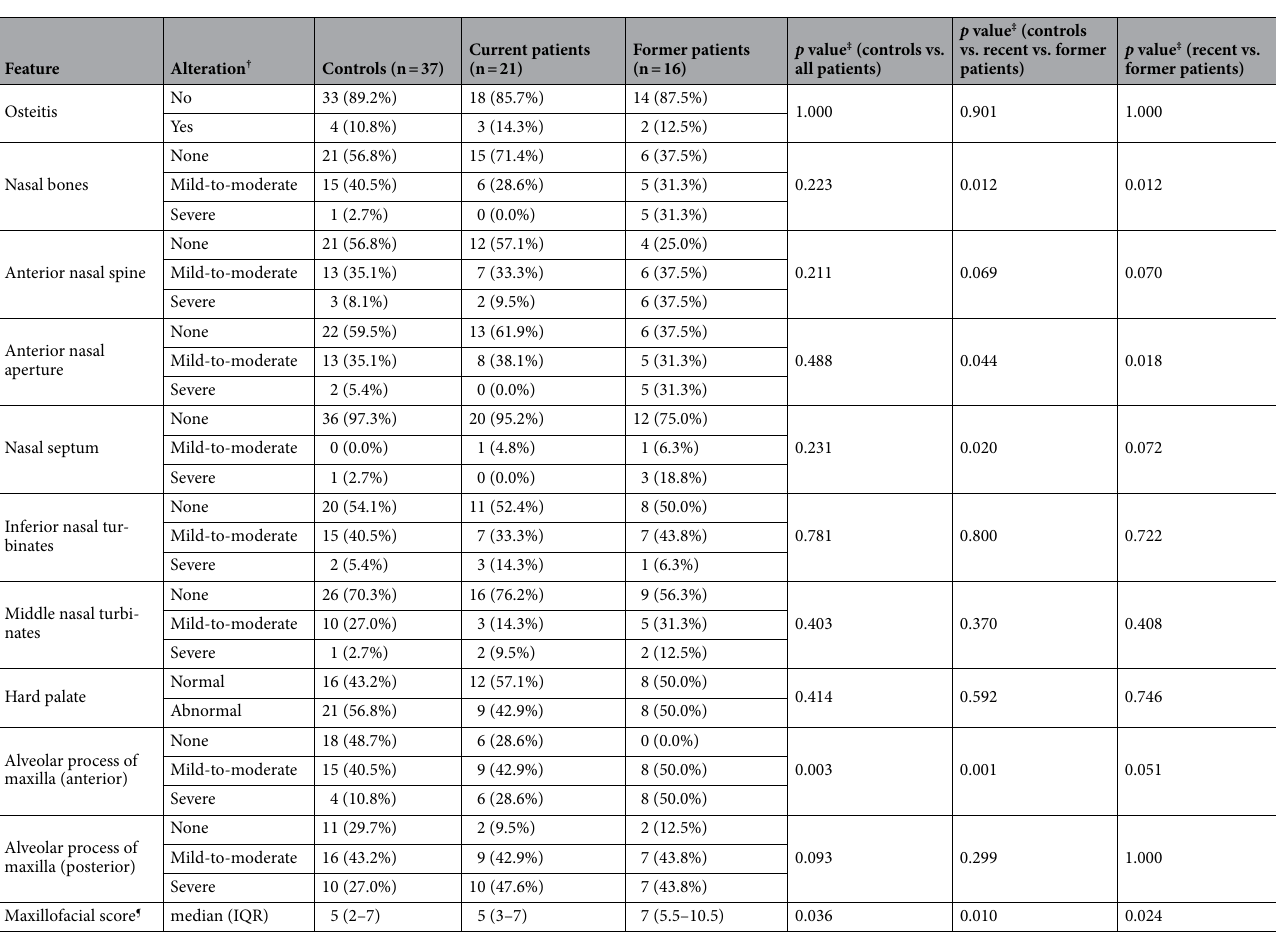
Table 1. Maxillofacial bone alterations in current and former Hansen’s disease patients and controls. † Degree of resorption/atrophy for all features except osteitis (present/absent) and hard palate (normal/thinning with bony discontinuities). ‡ Fisher’s exact (categorical variables) or Kruskal–Wallis test (maxillofacial score). ¶ A maxillofacial bone alteration score was calculated as a sum of the score for each feature, where no change was scored 0, mild-to-moderate alterations 1, and severe 2. This yielded a theoretical range of